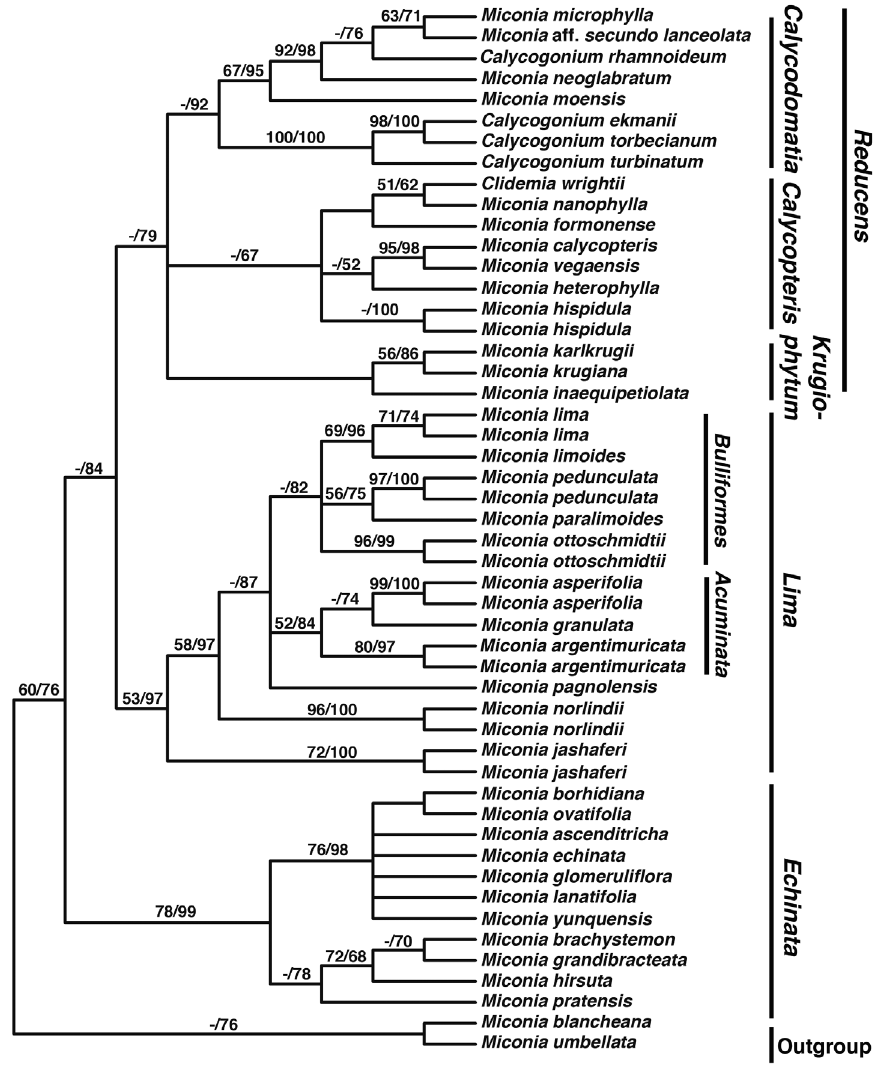
Figure 2. Maximum Parsimony 50% majority rule phylogeny of selected members of the Lima , Calycop- teris , Calycodomatia , Pseudolima , and Paralima clades (modified from Majure et al. 2015). Miconia umbel- lata and M. blancheana were used as outgroup taxa. Bootstrap values from both maximum parsimony/ maximum likelihood analyses are given above